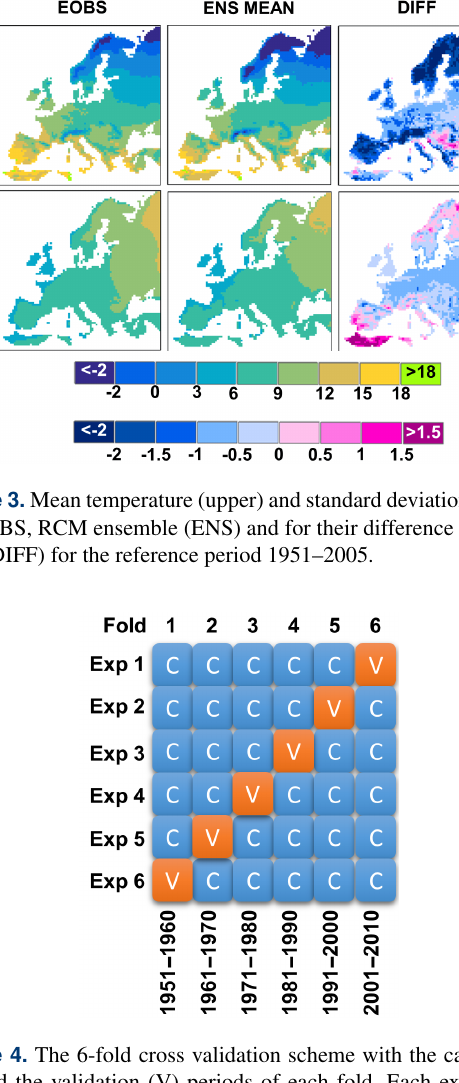
Table 1. RCMs used in this experiment.